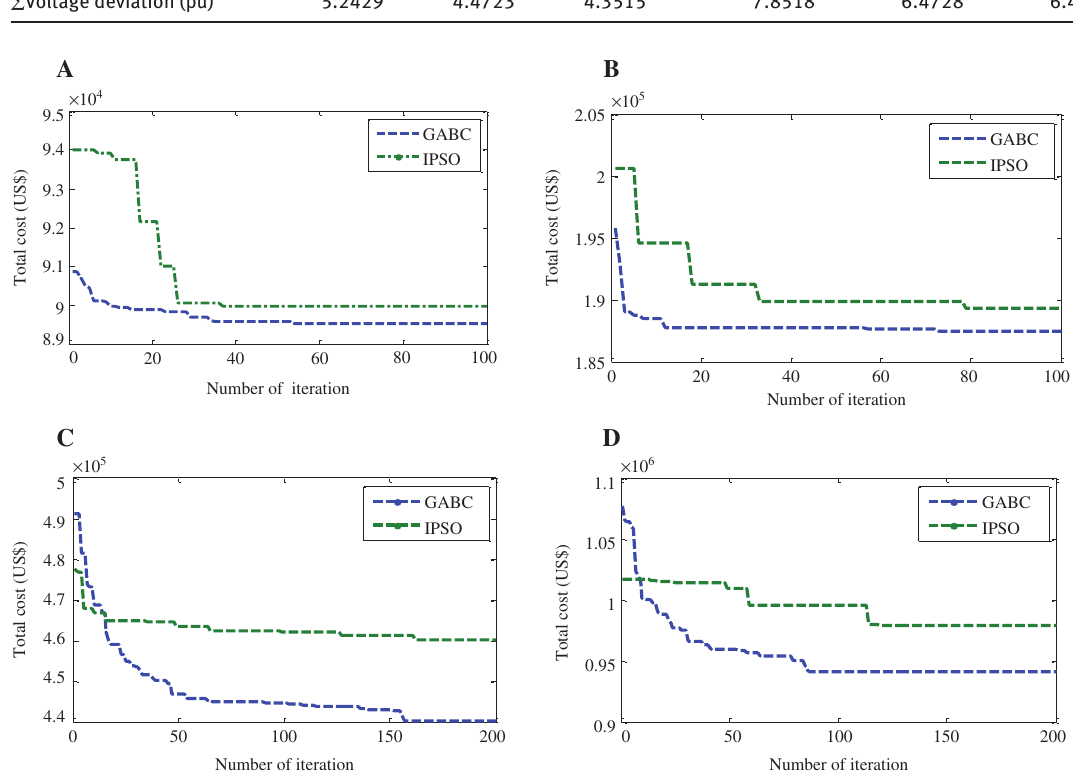
Figure 4: Convergence Characteristic Performance of GABC and IPSO. (A) For 34 buses without load growth. (B) For 34 buses with load growth. (C) For 118 buses without load growth. (D) For 118 buses with load